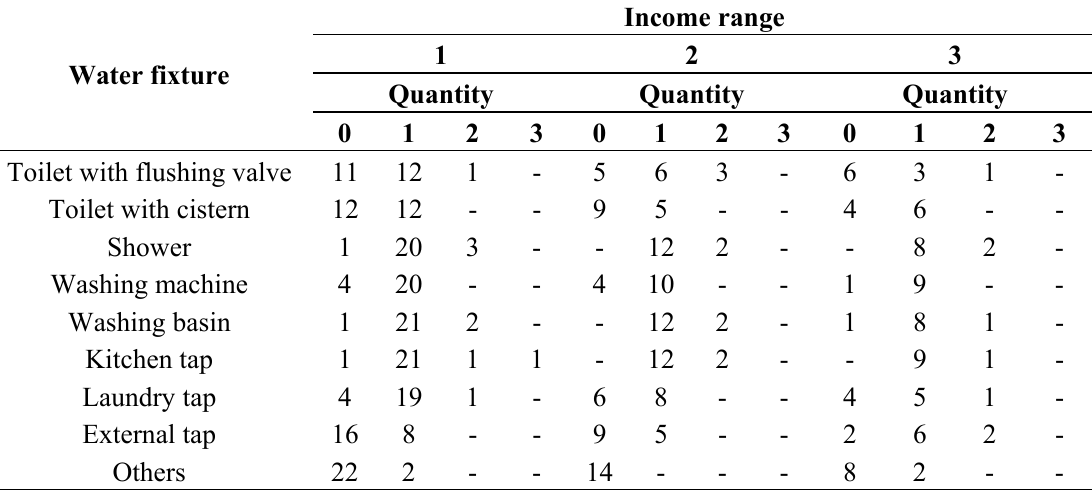
Table 1. Quantity of water appliances or fixtures per income